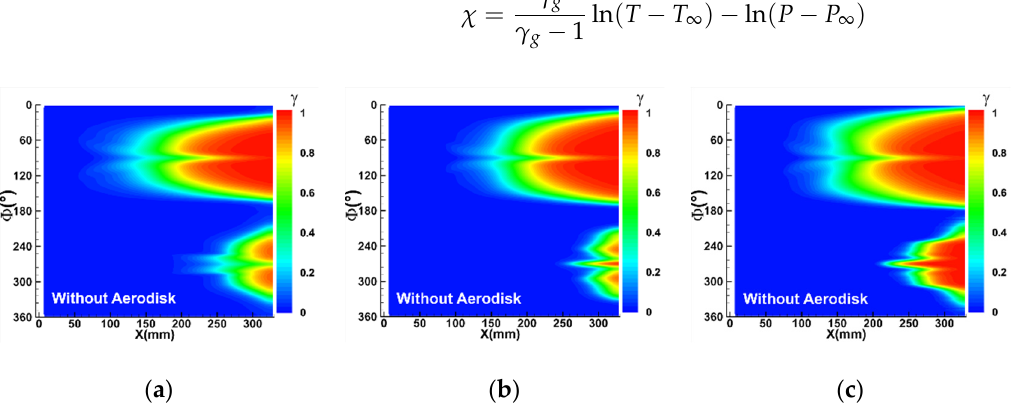
Figure 17. Distributions of γ without aerodisk at α = 2°,4°,6°. ( a ) α = 2°, ( b ) α = 4°, ( c ) α = 6°.